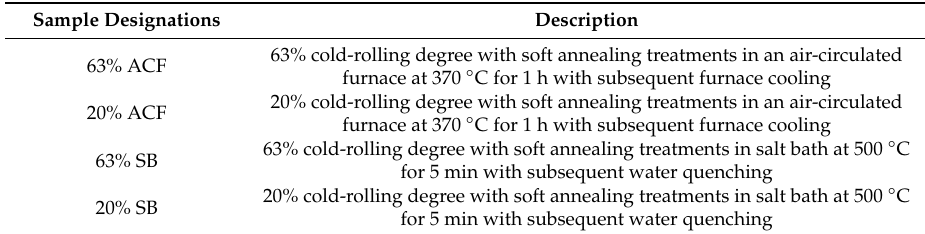
Table A1. Sample designation and detailed sample description.